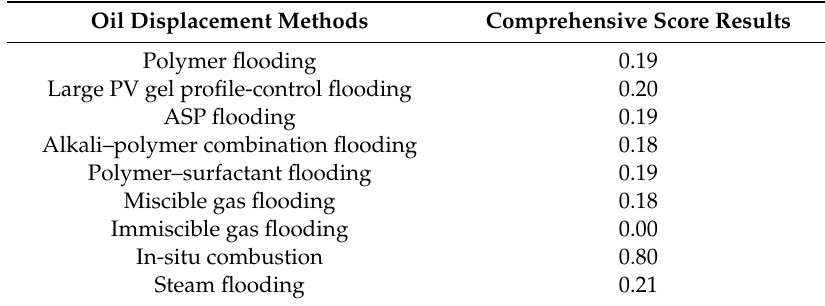
Table 3. Comprehensive scoring results of the method of screening. ASP: